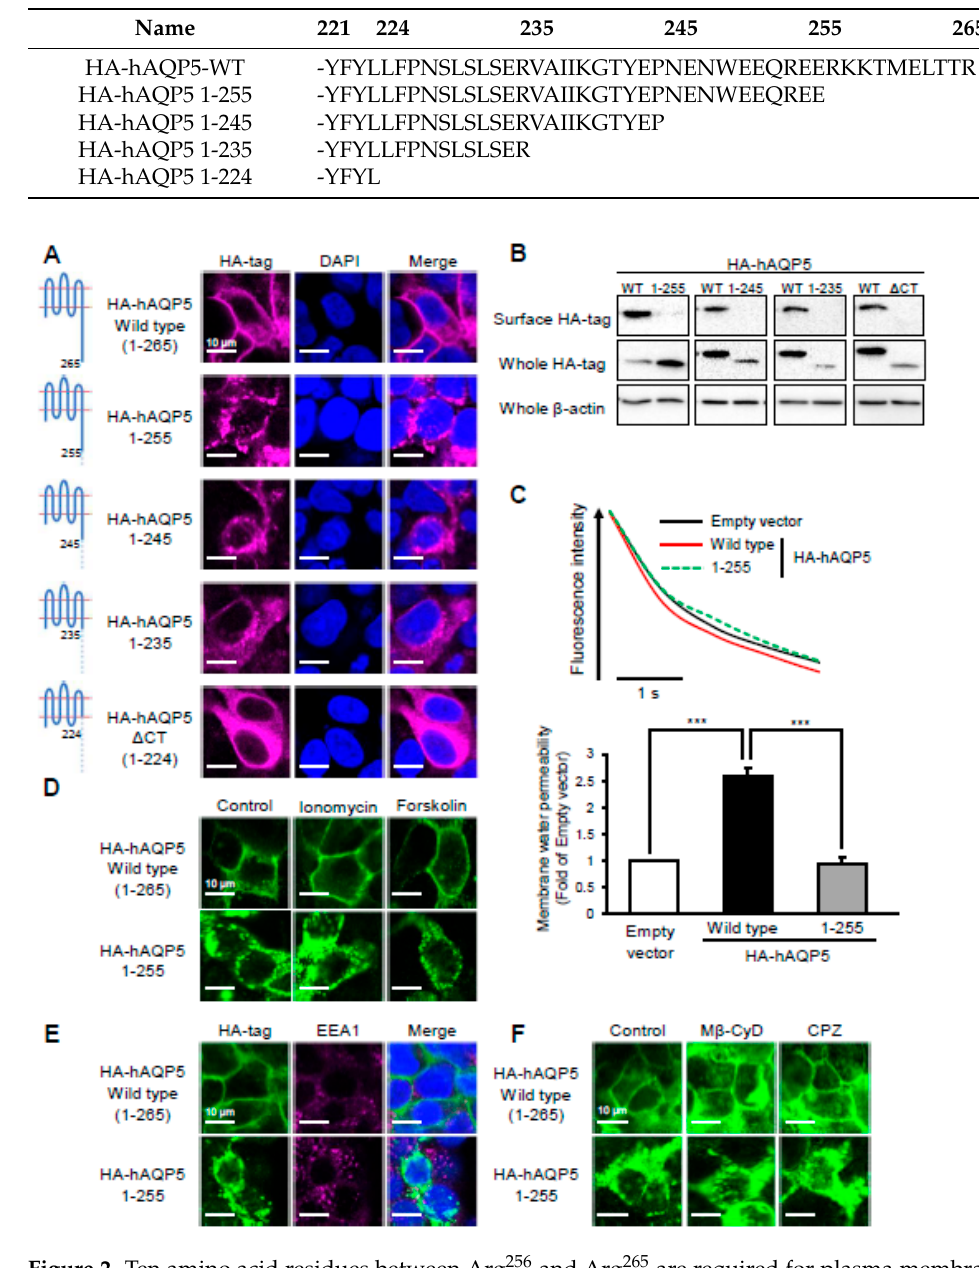
Figure 2. Ten amino acid residues between Arg 256 and Arg 265 are required for plasma membrane localization of AQP5. HEK-293 cells transfected with hAQP5 C-terminal deletion mutants were analyzed for the cellular localization of the mutants by immunofluorescence ( A ) and assessed for the level of cell surface mutants by cell surface biotinylation and Western blotting ( B ). Membrane water permeability of CHO-K1 cells transfected with hAQP5 1–255 was measured using the calcein quenching method at 37 ◦ C. Each data point represents mean ± SE ( n = 3), *** p < 0.001 ( C ). HEK-293 cells transfected with hAQP5 1–255 were treated with ionomycin (1 µ M) or forskolin (10 µ M) for 15 min. The cellular localization of the mutants was analyzed by immunofluorescence ( D ). HEK-293 cells transfected with hAQP5 1–255 were analyzed for the cellular localization of the mutants and EEA1 by immunofluorescence ( E ). HEK-293 cells transfected with hAQP5 1–255 were treated with methyl- β -cyclodextrin (M β -CyD, 1 mM) or chlorpromazine (CPZ, 10 µ g/mL) for 12 h. The cellular localization of the mutants was analyzed by immunofluorescence ( F ). Typical data in triplicated experiments are